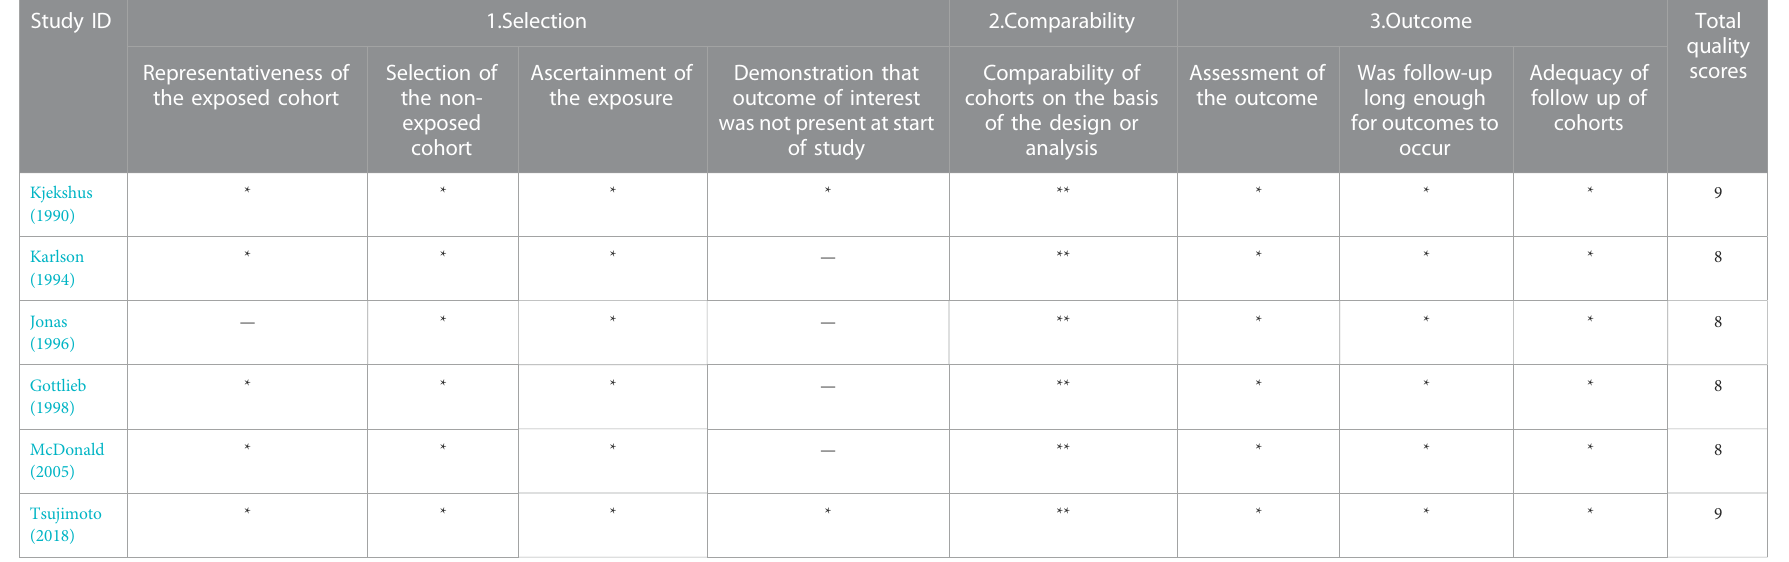
Indicates 1 points; ** indicates 2